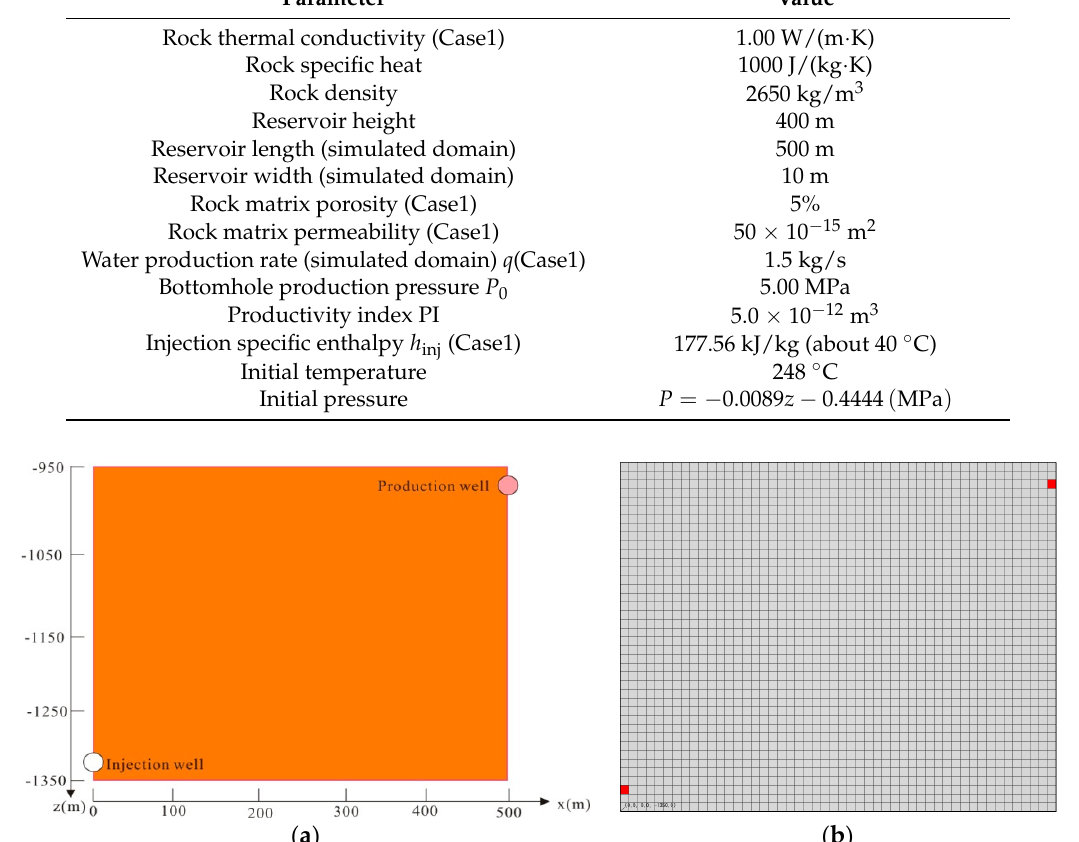
Table 3. The 950~1350 m reservoir properties and conditions at well ZK4001 [24,25].